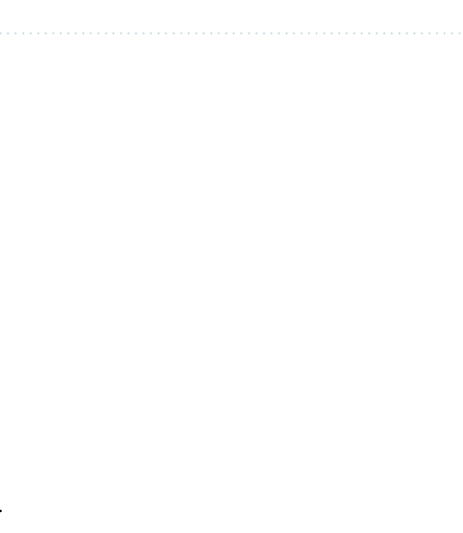
Table 1. Chemical properties of T. diversifolia fresh biomass and poultry manure. Values followed by similar letters under the same column are not significantly different at p = 0.05 according to Duncan’s multiple range test.